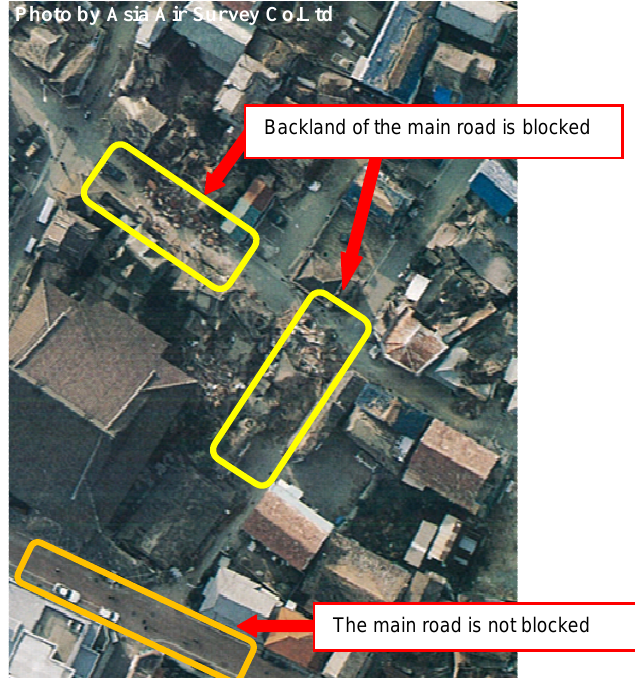
Figure.1 Roads blocked by Hanshin-Awaji Massive